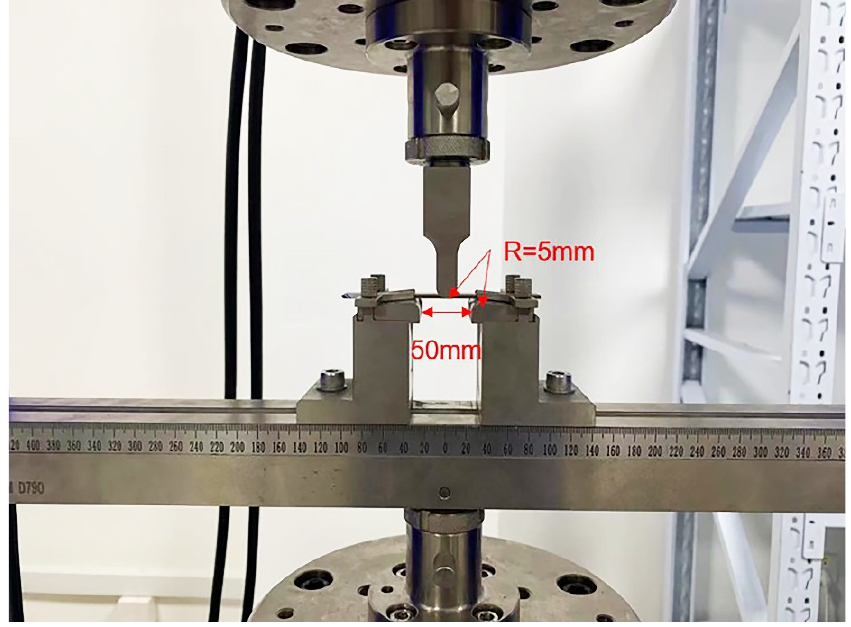
Figure 5. Experimental setup of the three-point bending test.